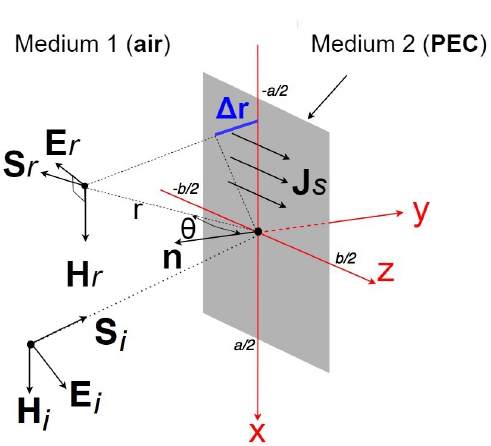
Figure 1. Magnetic field radiated by a rectangular plate.